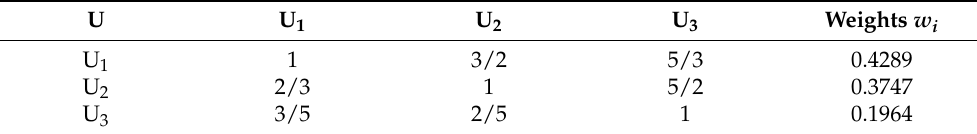
Table 5. Judgment matrix U–U i